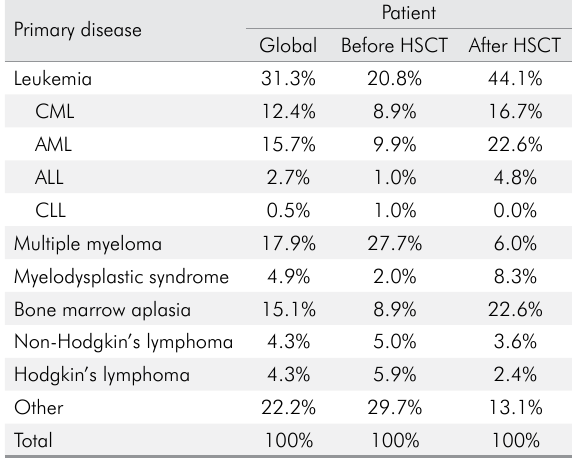
Table 2. Percentages of systemic diseases exhibited by individuals enrolled in the Program of Dental Care for Transplanted Patients,